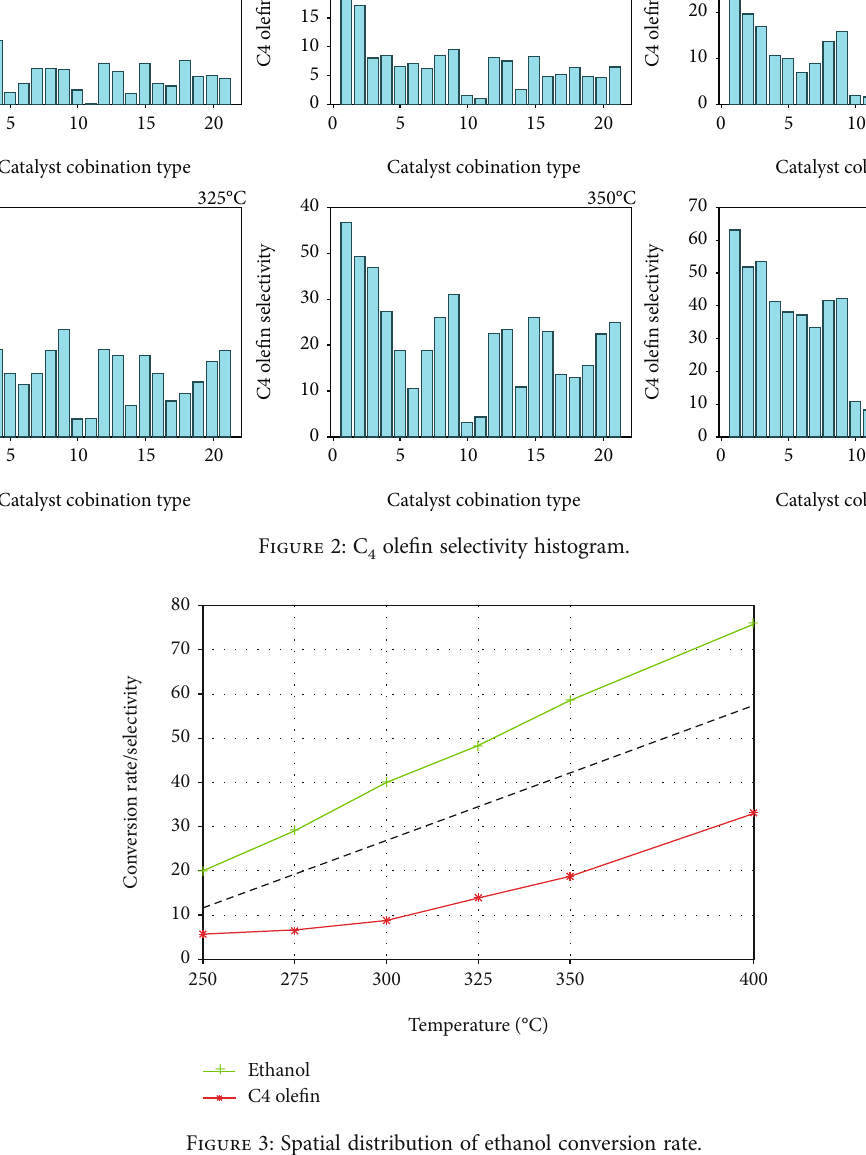
Figure 3: Spatial distribution of ethanol conversion